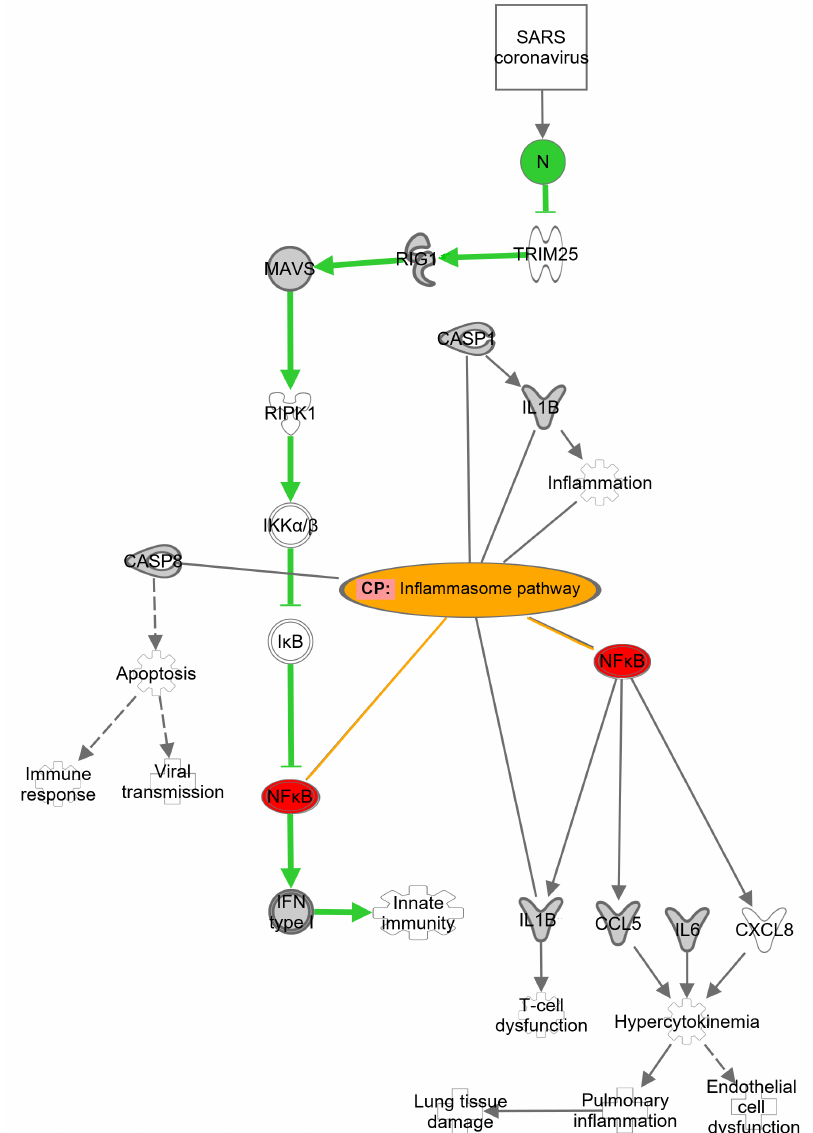
Figure 10. SARS-CoV-2-related signaling pathways in host cells. Green: NP-regulated pathway. Orange: Inflammasome pathway. Red: Connection of NF- κB to NP -regulated and inflammasome pathways.